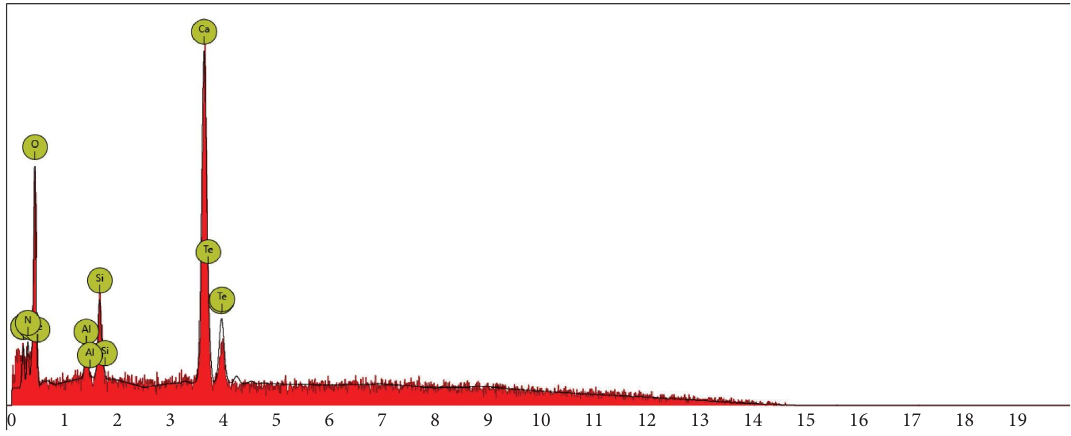
Figure 32: Graphical representation of elements concentration for M3 sample 800 ° C.